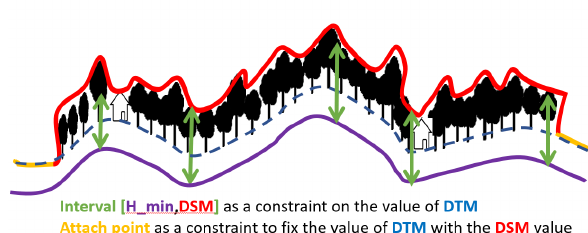
Figure 7. Constraints on the DTM values to inject in the physical simulation.